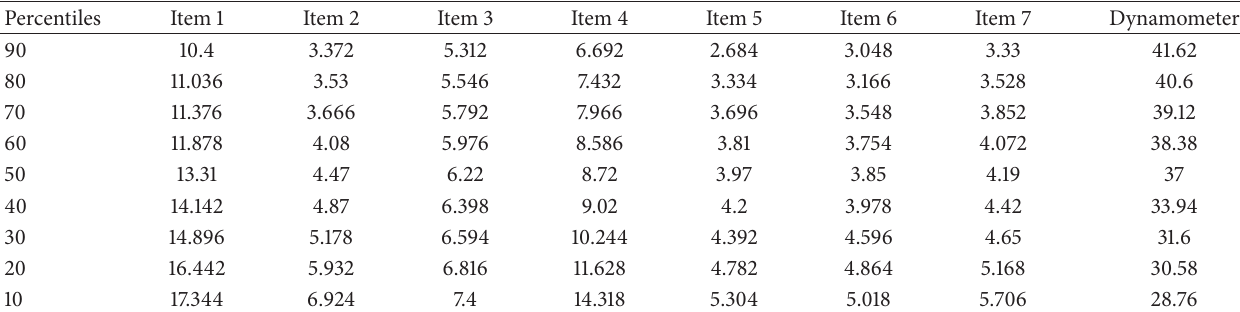
Table 17: 𝑛 = 21 , males, 6–19, dominant hand, educational instruction: elementary school.